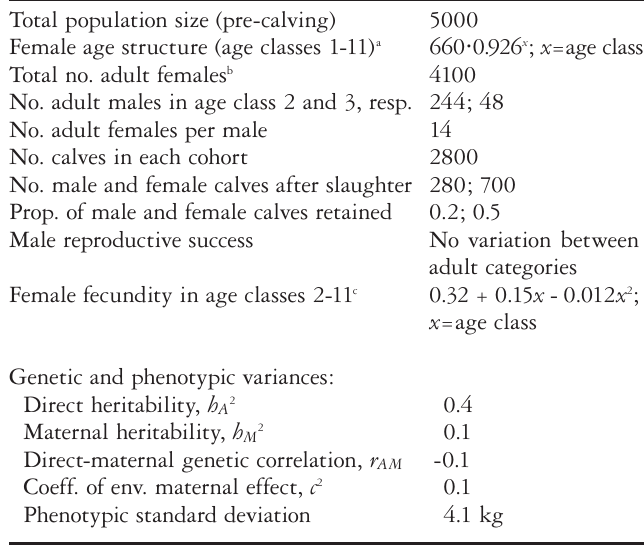
Table 1. Input parameter